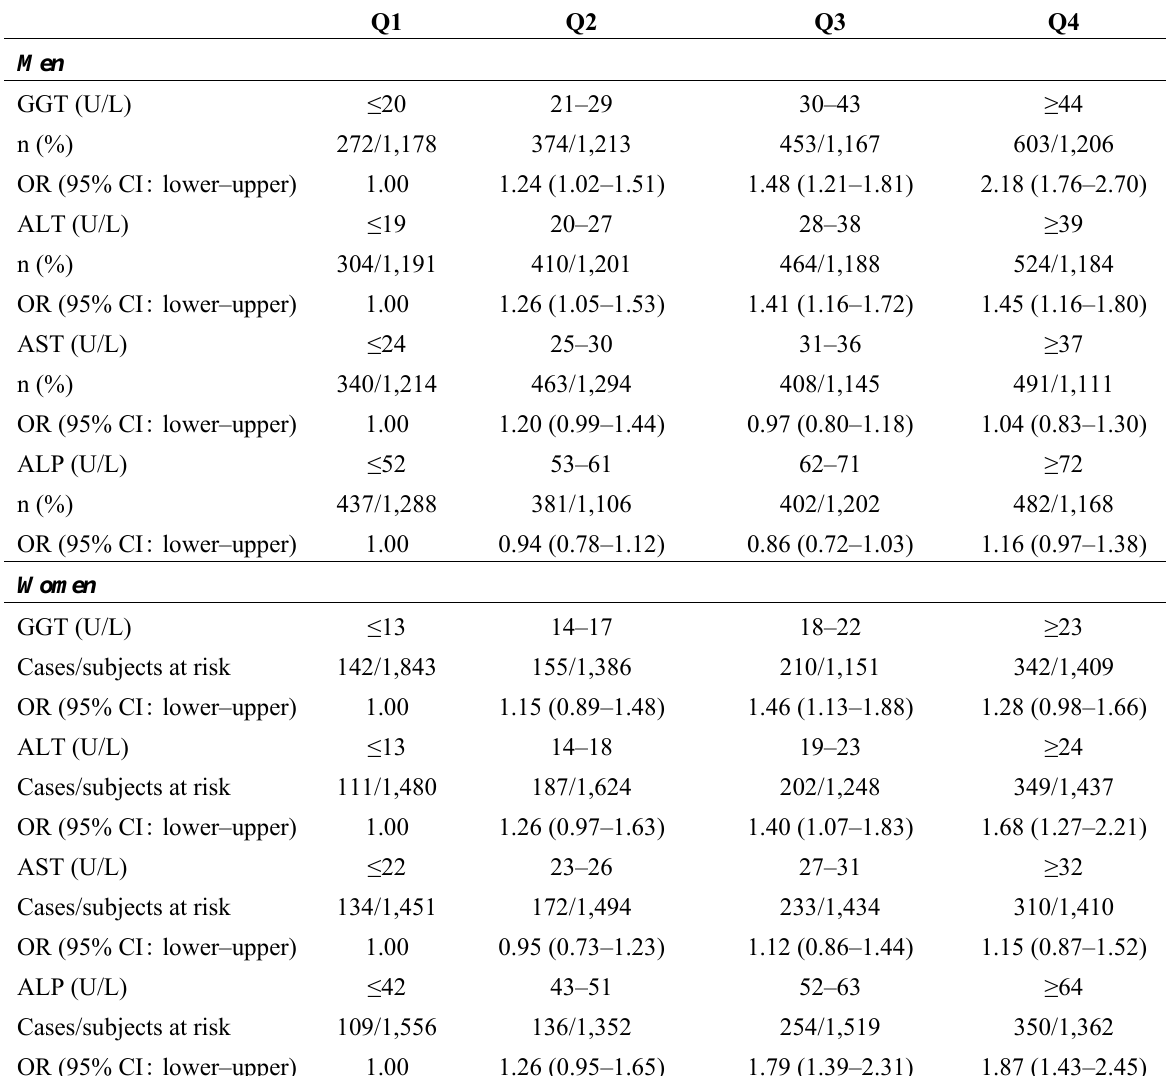
Table 4. Factors associated with elevated BP by